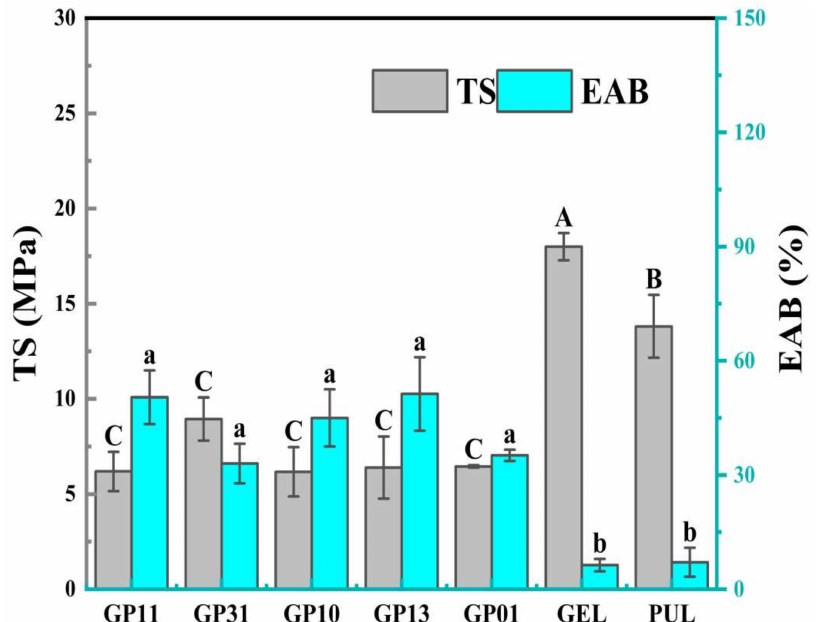
Figure 4. Tensile strength (TS) and elongation at break (EAB) of different films. (Different letters in the same data indicate significant differences ( p <